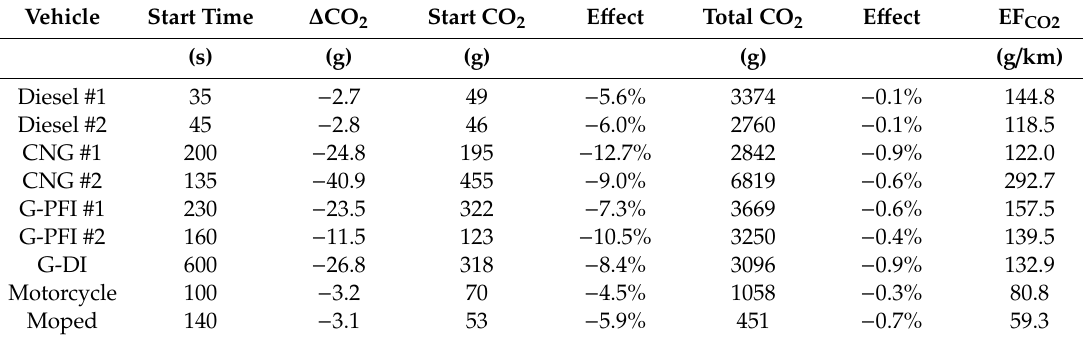
Table 5. E ff ect of condensation on CO 2 mass emissions for the beginning (start) of the cycle and the full (total) cycle (WLTC or WMTC for two-wheelers). “ ∆ CO 2 ” stands for the di ff erence between the CO 2 mass emissions calculated using the K d-w,RDE and the K d-w,H 2 O for the start duration of the cycle given in column